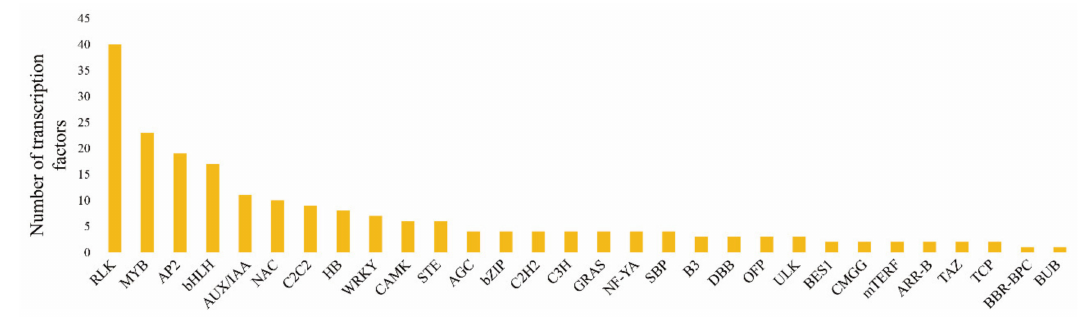
Figure 8. Transcription factor enrichment in +S and − S treatments. The x -axis and y -axis represent the transcription factors and their amounts in each classification,